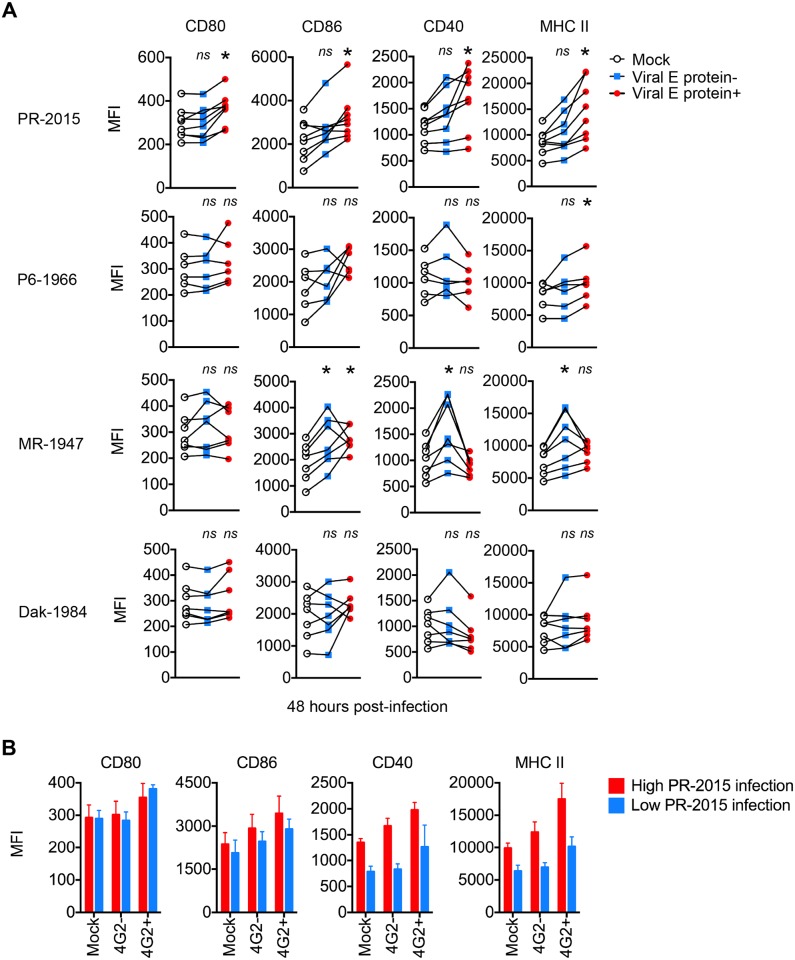
ZIKV infection minimally activates human DCs.(A) moDCs were left uninfected (“Mock”) or infected with PR-2015, P6-1966, MR-1947, or Dak-1984 at MOI of 1 (n = 6–8 donors). Cells were collected at 48hpi and labeled for ZIKV E protein and indicated DC activation markers. Cells were categorized as being viral E protein- or viral E protein+ and activation marker surface expression quantitated by flow cytometry. Values are represented as median fluorescence intensity (MFI) for each individual donor with uninfected and ZIKV infected samples from the same donor connected with a line. Statistical significance (p< 0.05) was determined using a Friedman test with comparisons made to donor-paired, uninfected cells. (B) moDCs infected with PR-2015 at MOI of 1 were stratified into “low” (n = 3 donors) and “high” (n = 5 donors) infection on the basis of viral E protein staining. MFIs are shown as the mean +/- SD. See also S3 Fig.